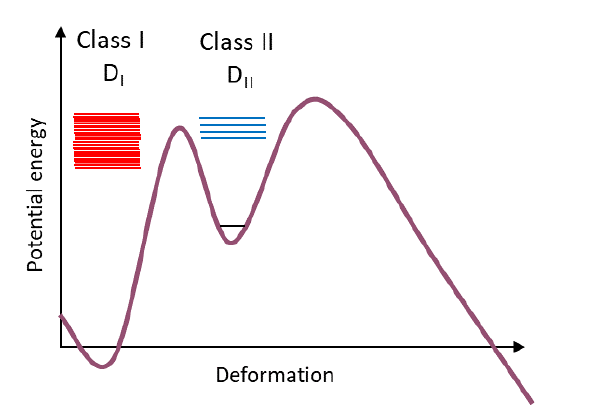
Figure 4. Classification of compound nuclear states into Class I states with average spacing of D I with the main amplitude in the first well and the class II states and average level spacing D II belonging to the second well.